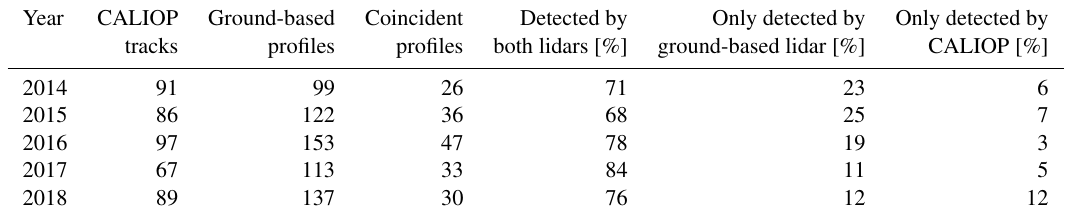
Table 1. The number of available data and the detection statistics of both lidars have been listed. The column “detected” indicates when both ground-based lidar and CALIOP detect a PSC or they do not detect a PSC in the same vertical bin. The other two columns indicate all cases when only one of the instruments detects a PSC in a specific vertical bin. Only bins below 26km have been considered, since very few PSCs have been observed above 26km. Year CALIOP Ground-based Coincident Detected by Only detected by Only detected by tracks profiles profiles both lidars [%] ground-based lidar [%] CALIOP [%]